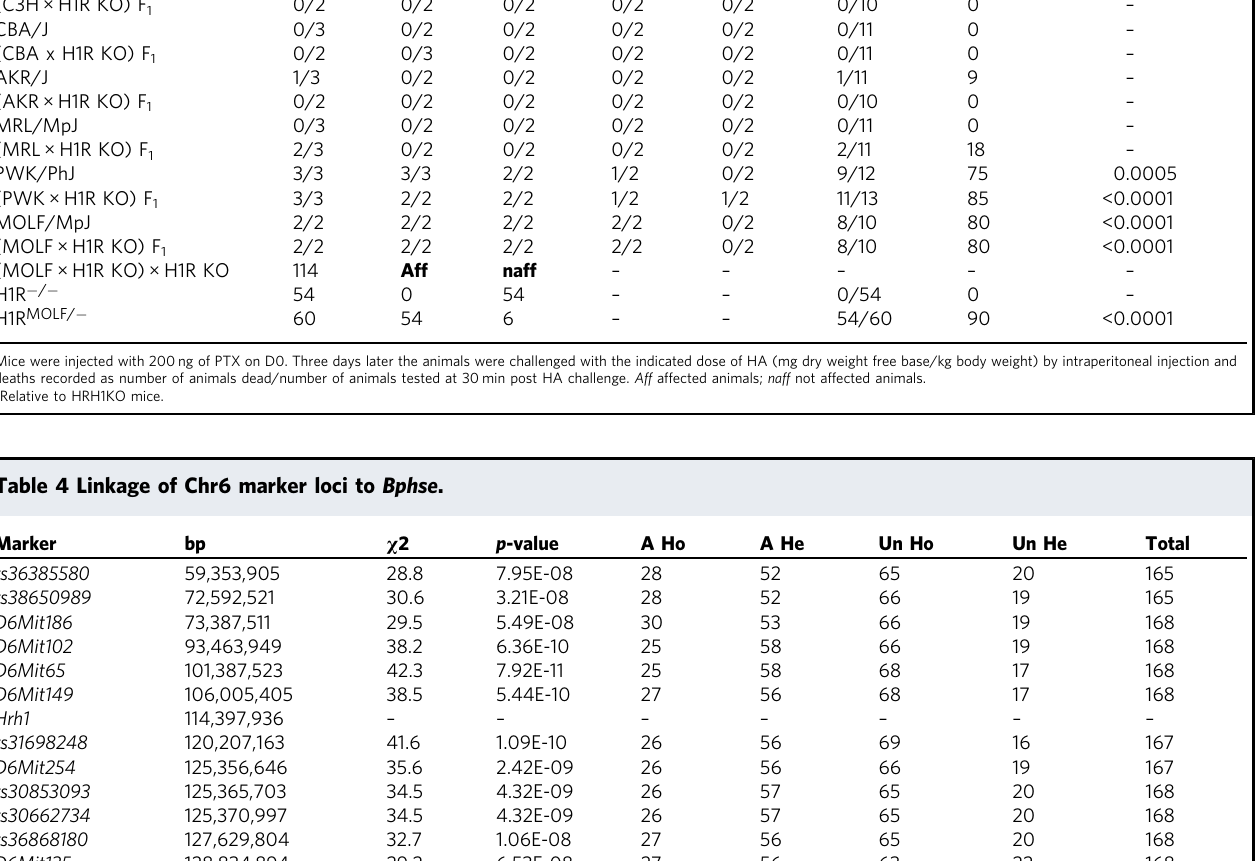
(Table 4). This phenotype mapped to Chr6: marker loci from